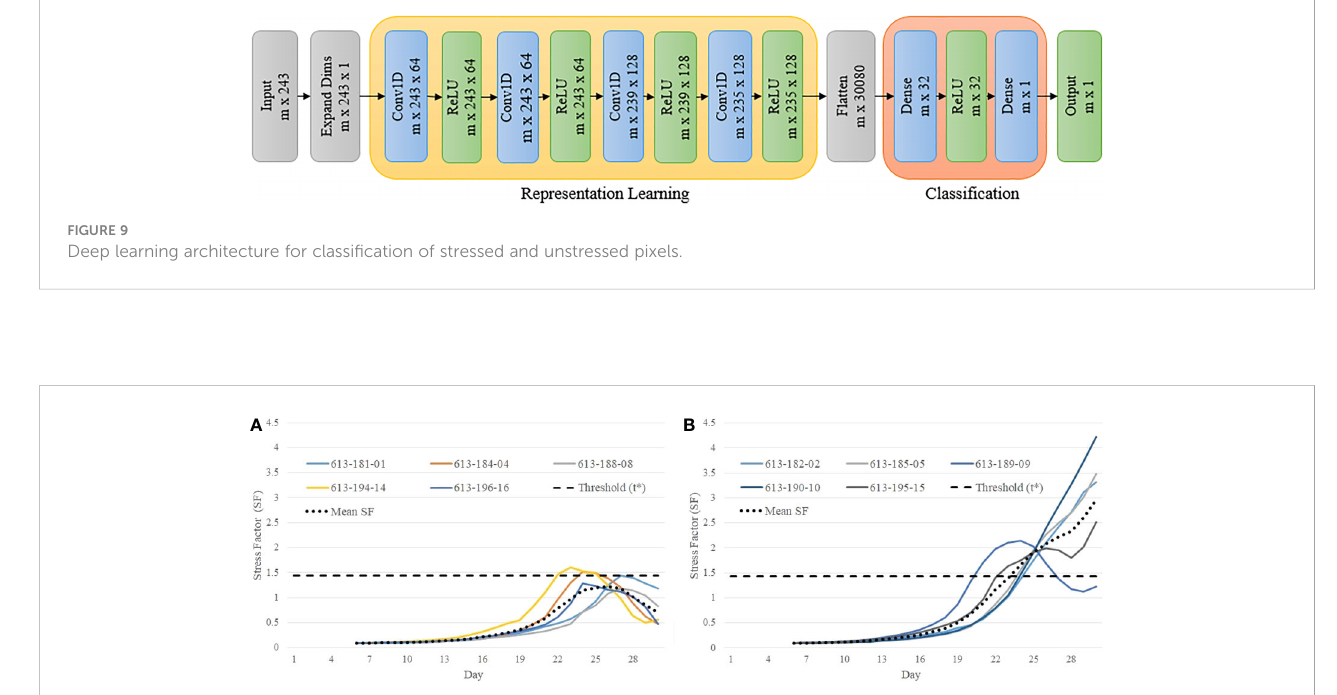
FIGURE 10 Illustration of difference in behavioral characteristics between control and stressed plants in terms of stress factor curves: (A) stress factor curves for control plants; and (B) stress factor curves for stressed plants.